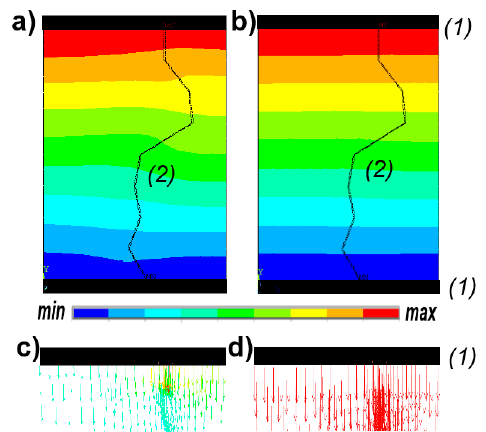
Figure 20. Electromagnetic field distribution ( a , b ) and electromagnetic field gradients ( c , d ) distribution for nonlinear parameters ( ε , ρ ) after 0.5 s ( a , c ) and 1 s ( b , d ) from previous discharge. 1—electrode; 2—geometry of previous discharge channel.